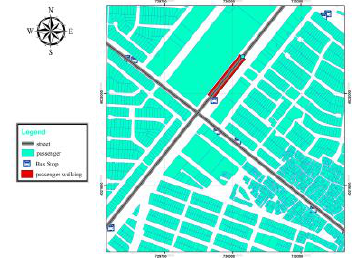
Figure. 9 An image showing the result from the system analysis